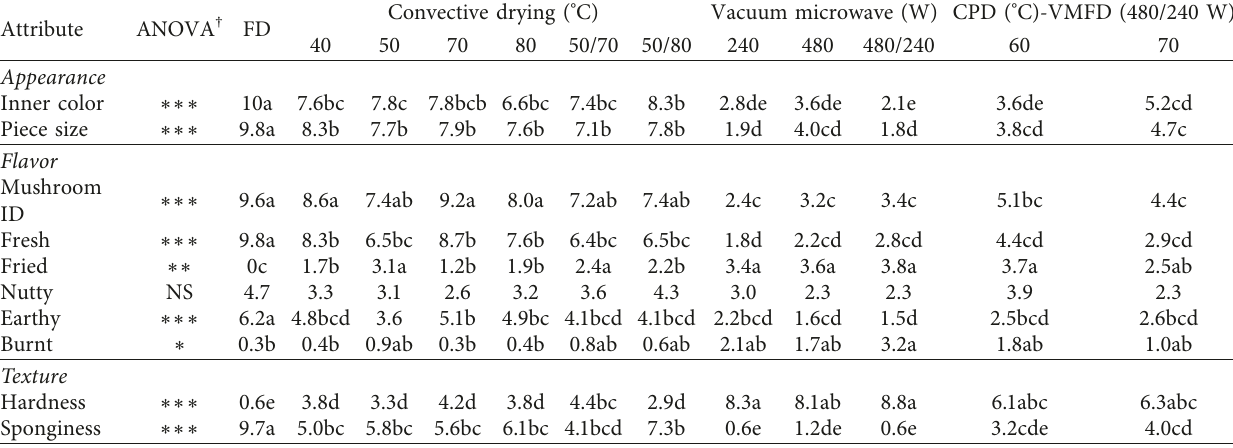
Table 4: Descriptive sensory profiles of Boletus edulis samples as affected by the drying method. Attribute ANOVA †